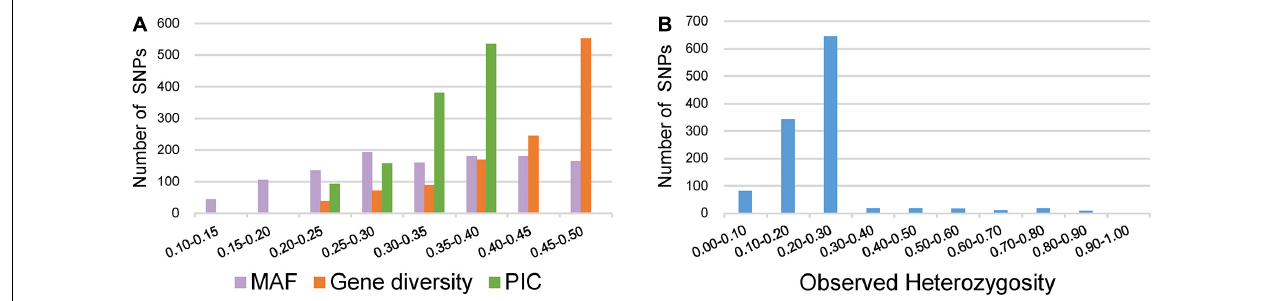
FIGURE 4 | Distribution of genetic diversity for 1,167 markers in the 372 broccoli accessions. (A) Minor allele frequency (MAF), gene diversity (GD), and polymorphic information content (PIC). (B) Observed heterozygosity.